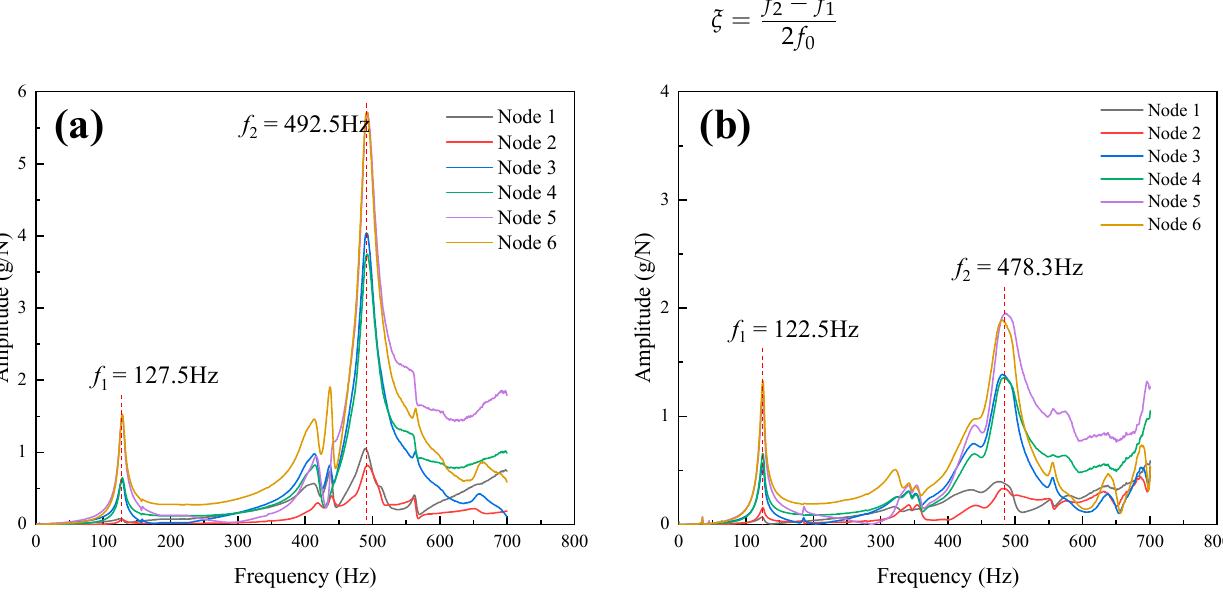
Figure 4. Experimental frequency response curves of two types of sandwich plates: ( a ) HP fc and ( b ) EBEP fc .